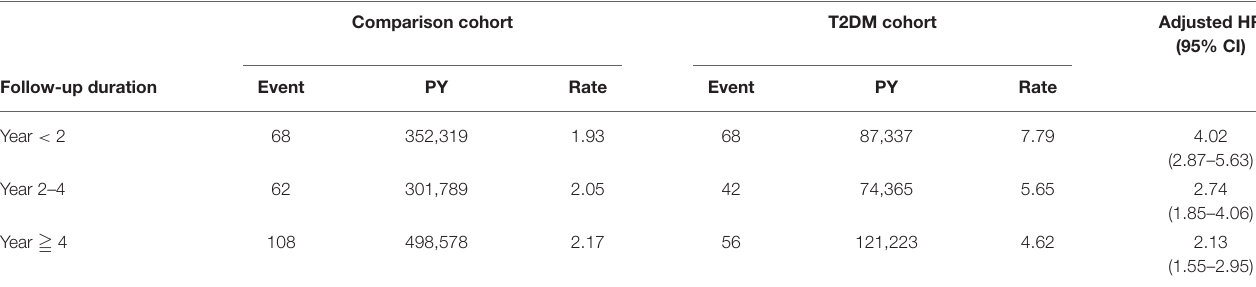
TABLE 5 | HRs for PLA, according to follow-up